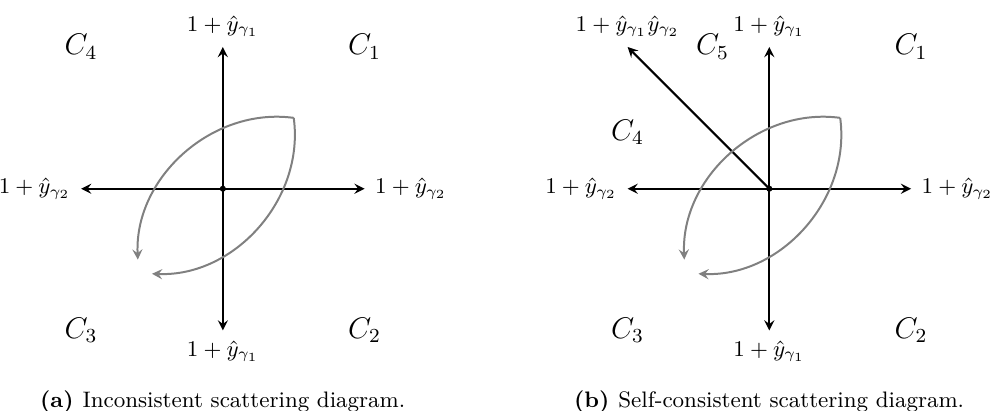
is not path independent, as shown in eq. (2.15). γ